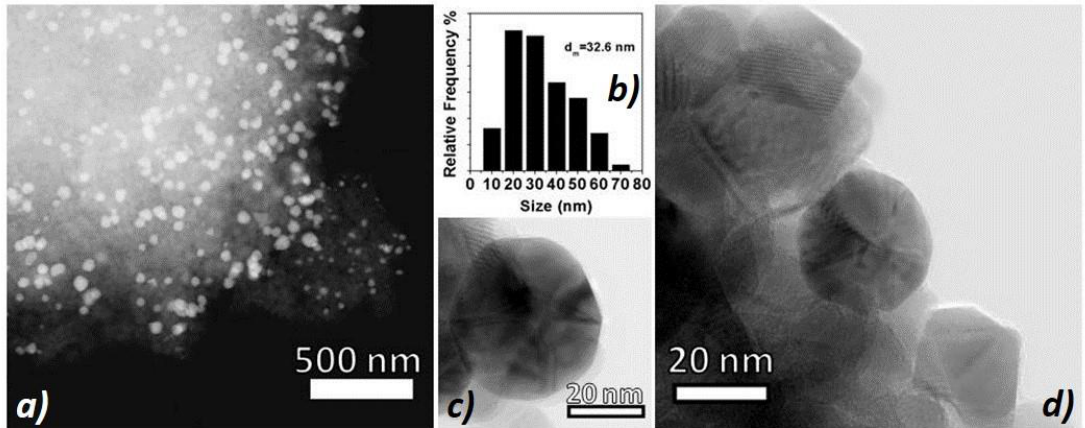
Figure 3. ( a ) A representative STEM micrograph of an Au/TiO 2 anatase sample at low magnification— Figure 3. (a) A representative STEM micrograph of an Au/TiO 2 anatase sample at low AuNPs (gold nanoparticles) appear brighter over the greyish support; ( b ) AuNPs size distribution magnification—AuNPs (gold nanoparticles) appear brighter over the greyish support; (b) AuNPs and representative HRTEM (High-Resolution Transmission Electron Microscopy) micrographs of ( c ) a size distribution and representative HRTEM (High-Resolution Transmission Electron Microscopy) gold NP and ( d ) a AuNP/TiO 2 NPs cluster where a AuNP appears rounder and slightly darker than micrographs of ( c ) a gold NP and ( d ) a AuNP/TiO 2 NPs cluster where a AuNP appears rounder and anatase slightly darker than anatase ones.